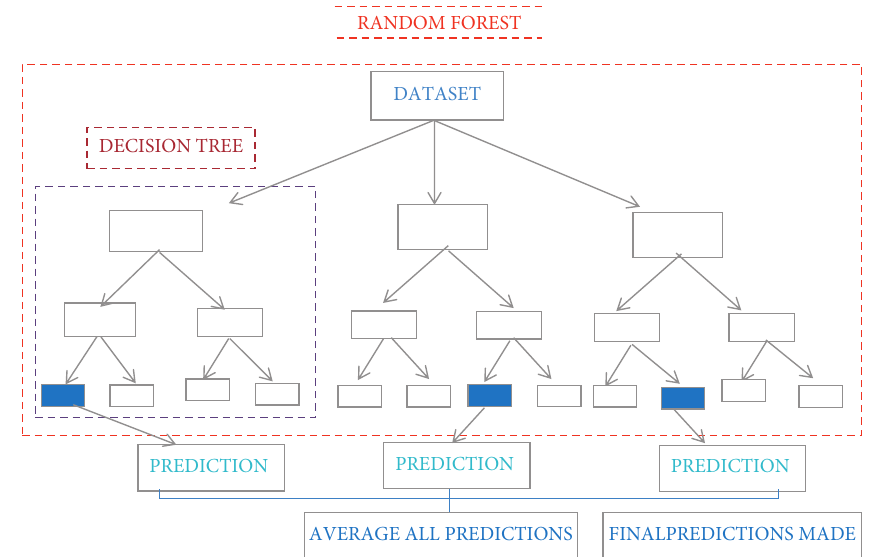
Figure 2: Structural flow of random forest